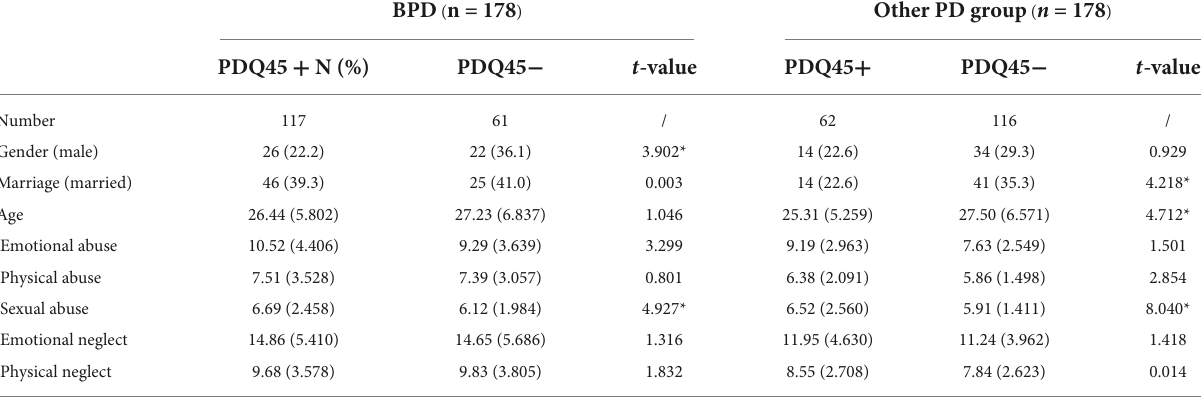
TABLE 3 Different PD groups with self-harm/suicidal behaviors vs. without self-harm/suicidal behaviors. BPD ( n = 178 ) Other PD group ( n = 178 ) PDQ45